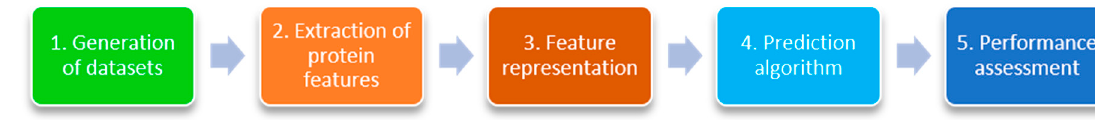
Figure 2. General steps involved in machine ‐ learning (ML) ‐ based PPI predictions. Table 3. Alphabetical listing of machine learning predictors for the identification of PPIs.